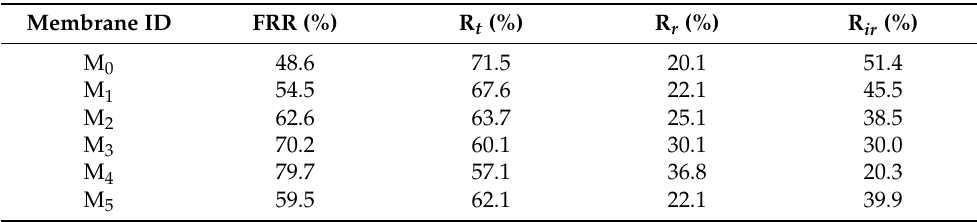
Table 3. Flux recovery ratio and fouling resistance data of pristine and composite membranes.